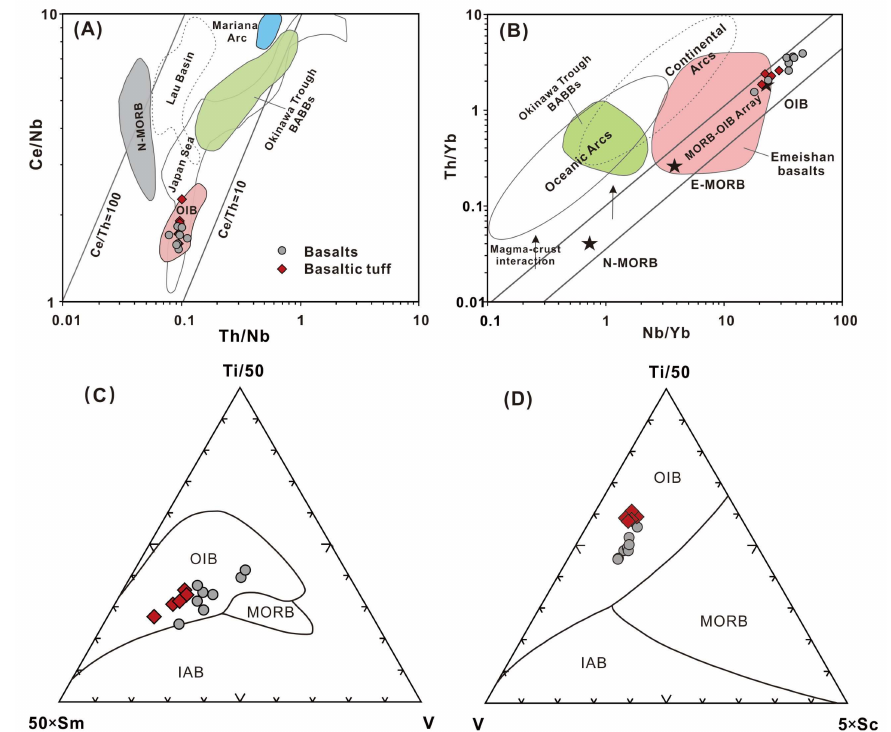
Figure 14. Discrimination diagrams of mantle source for the Laochang volcanic rocks. ( A ) Th/Yb vs. Ce/Nb diagram from Sandeman et al. [91] and Taylor and Martinez [92]; ( B ) Nb/Yb vs. Th/Nb diagram. Discrimination fields of oceanic arcs, continental arcs, Mariana Trough back-arc basin basalts (BABBs) and mid-ocean ridge basalt (MORB)—oceanic island basalt (OIB) mantle array are from Pearce [93–95]. ( C ) Ti/50–50 × Sm–V ternary diagram and ( D ) Ti/50–50 × Sm–V ternary diagram from Vermeesch et al.